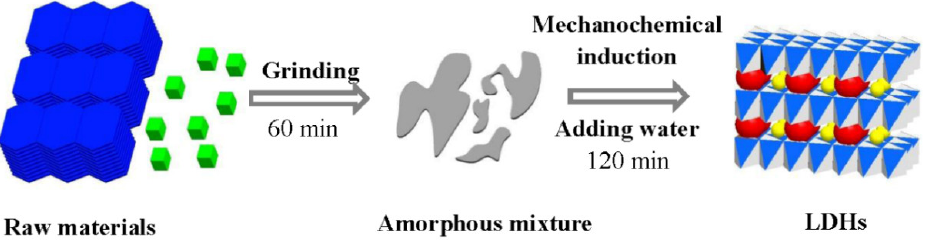
Figure 2. Illustration of the two-step grinding operation. Reproduced with permission from [3].